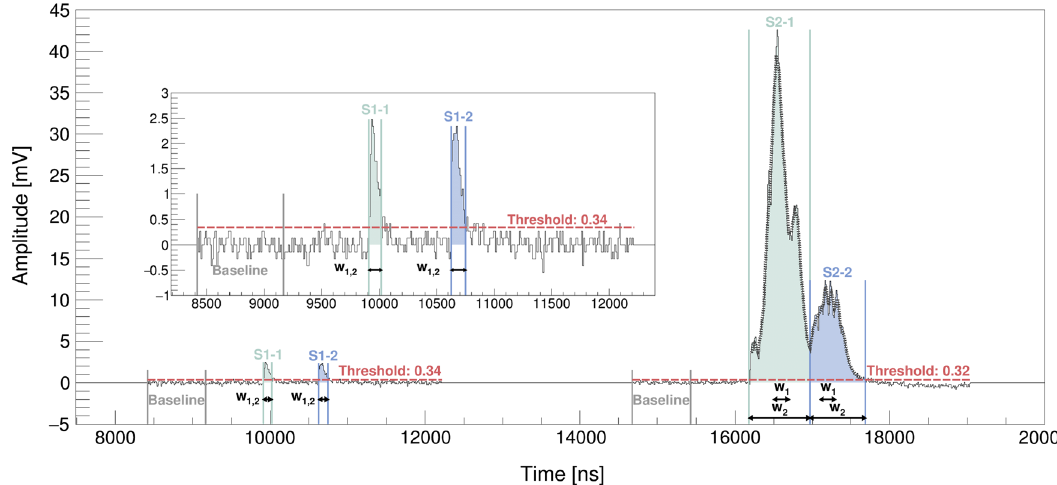
Fig. 3 Recorded SiPM waveform of a 83m Kr event acquired with ZLE. For visualisation, we present the relevant region of the 40 µ s DAQ win- dow of an event from a SiPM channel located at an outer corner of the array that exhibits small S2 signals for events in the horizontal center of the TPC. The peaks are located in two good-regions surrounded by 150 backward- and forward-samples with skipped-regions in between. The integration windows are shaded and enclosed by lines. The base- line, from which the threshold is defined, is calculated individually for each good-region. While for disjointed good-regions, like here, it is based on the first half of the backward-samples, for two consecutive